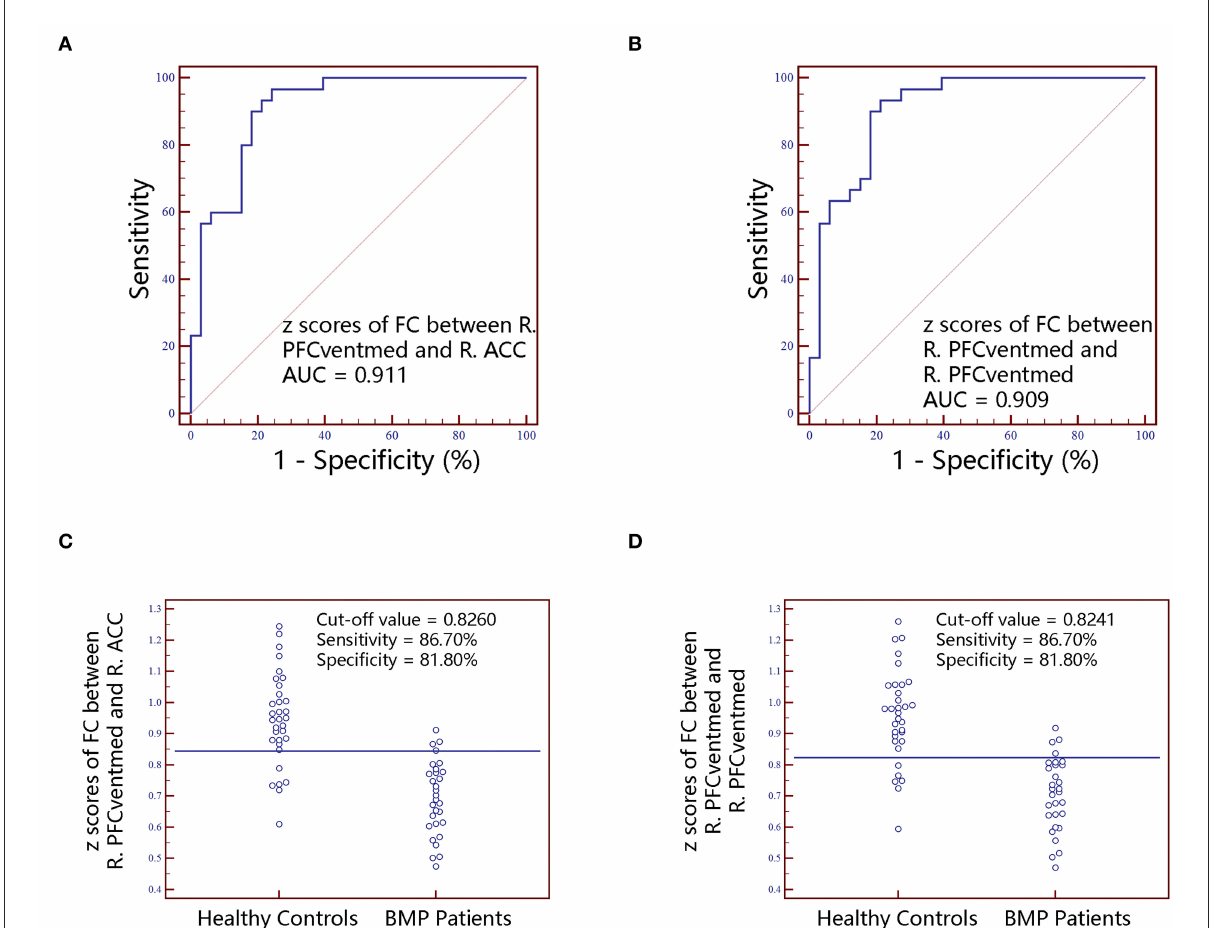
FIGURE5 The classification performance of FC z scores extracted from individual brain regions identified by intergroup comparison. The top row are receiver operating characteristic curves for z scores of FC between R.PFCventmed and R.ACC (A) and z scores of FC between R.PFCventmed and R.PFCventmed (B) . The bottom row are interactive dot diagrams for z scores of FC between R.PFCventmed and R.ACC (C) and z scores of FC between R.PFCventmed and R.PFCventmed (D) . FC, functional connectivity; AUC, areas under receiver operating characteristic curve; ACC, anterior cingulate cortex; PFCventmed, superior frontal gyrus, medial orbital; R, right; L,